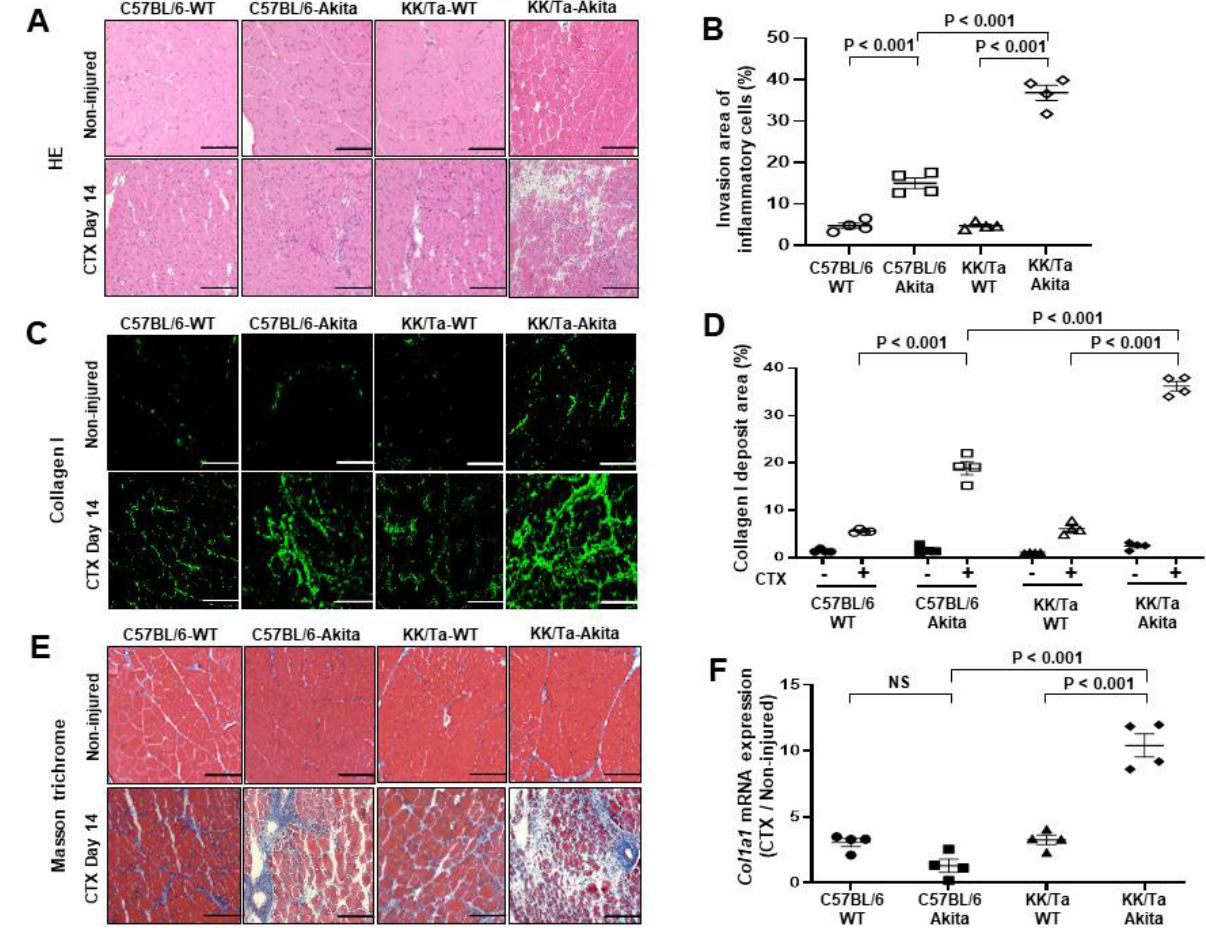
Figure 2. Inflammatory and fibrotic changes in TA muscles on day 14 after saline (non-injured) or CTX injection. ( A ) Representative images of HE staining in TA muscles. ( B ) Invasion area of HE-stained inflammatory cells in TA muscles on day 14 after CTX injection. ( C ) Representative images of collagen I immunofluorescent staining in TA muscles. ( D ) Analysis of collagen I deposit area in collagen I-stained images in TA muscles on day 14 after CTX injection. CTX − and CTX + indicate saline and CTX injection, respectively. ( E ) Representative images of Masson trichrome staining in TA muscles. ( F ) Col1a1 mRNA expression analysis in TA muscles on day 14 after CTX injection. Bars = 200 µ m for all images. Data are presented as means ± SEM. n = 4 per group.